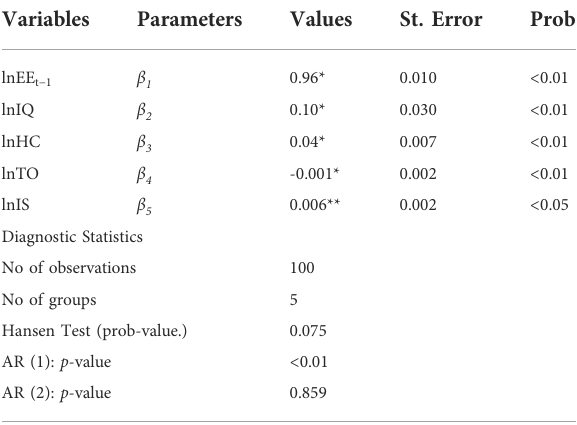
TABLE 5 Results of the system GMM